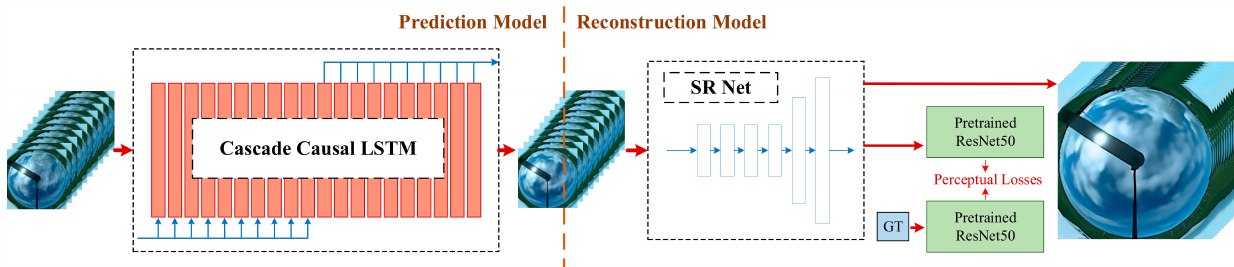
Figure 1. Schematic diagram of the overall structure of the model. The left side is the prediction model, and the right side is the super-resolution reconstruction model.